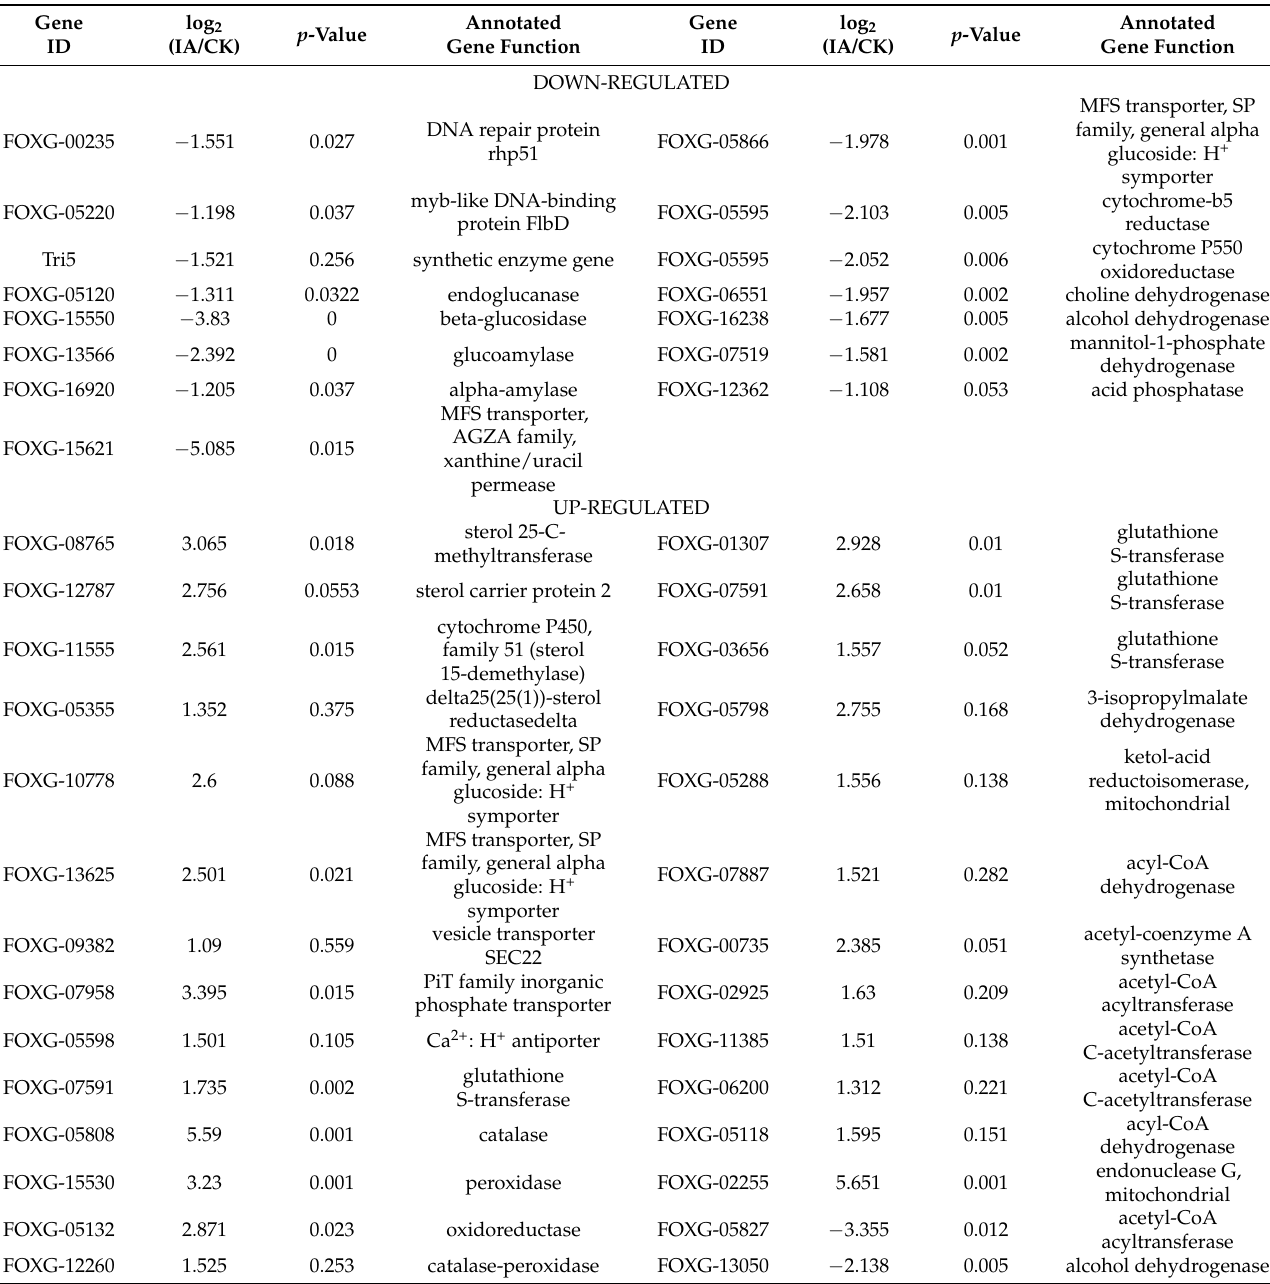
Table 2. Differentially expressed genes in F. oxysporum exposed to 25 µ g/mL iturin A compared with the